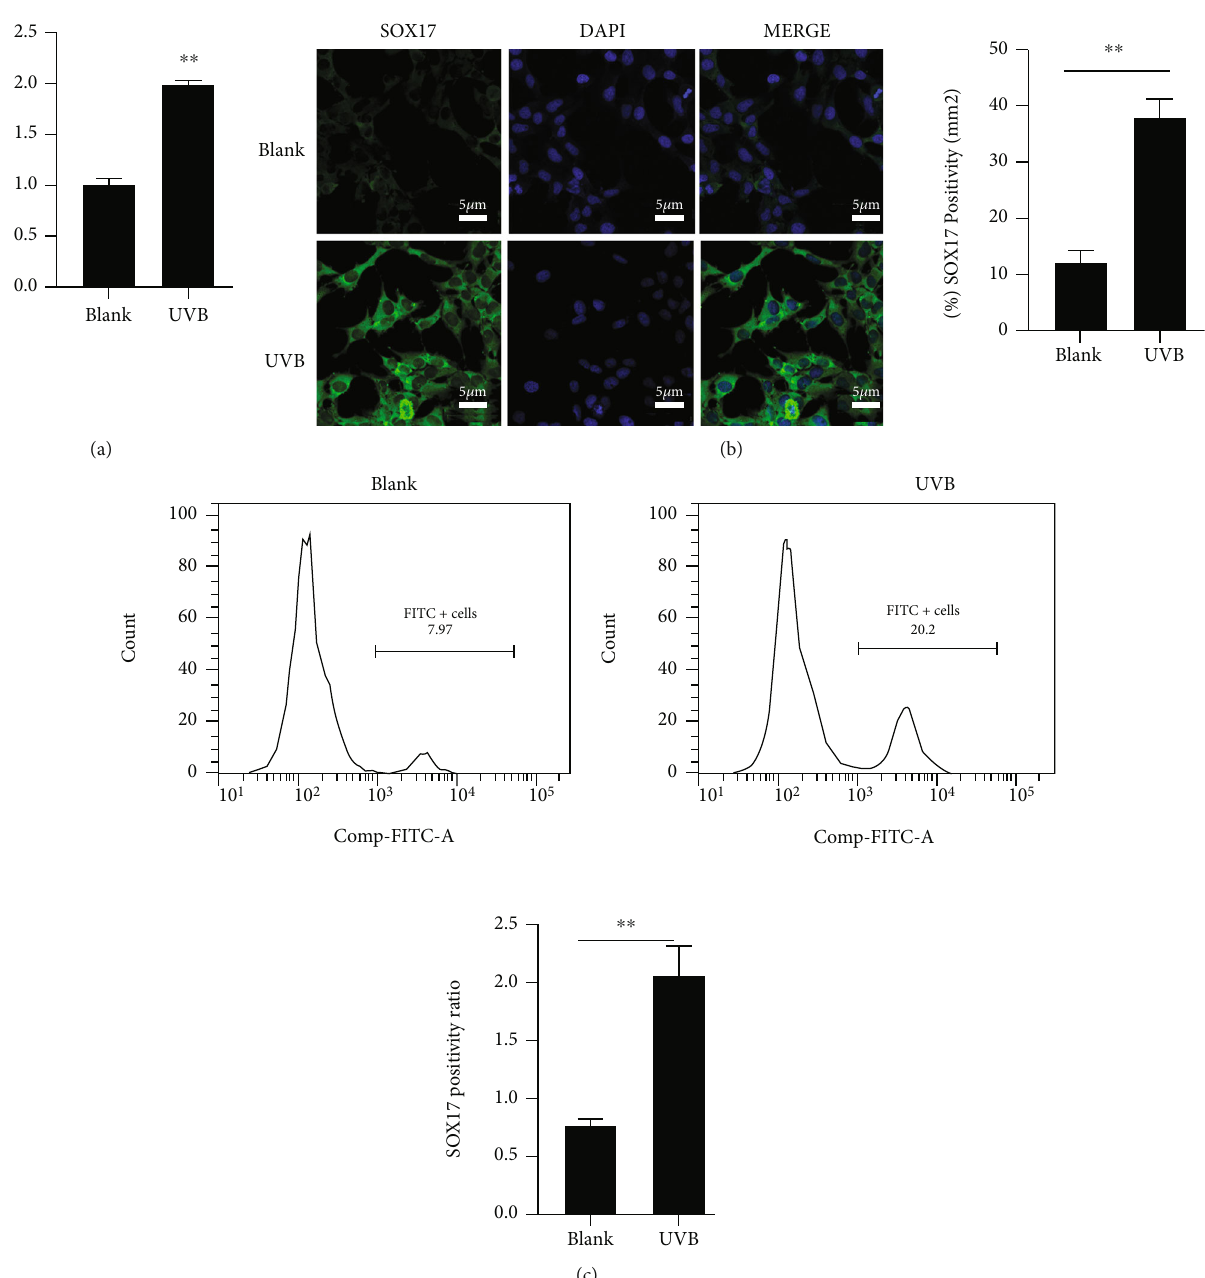
Figure 5: Ultraviolet B (UVB) irradiation enhances SOX17 expression in murine KCs post-UVB irradiation. (a) qRT-PCR determination of SOX17 mRNA expression in KCs following UVB irradiation. (b) Immuno fl uorescence analysis of SOX17 expression in KCs following UVB irradiation. (c) FCM detection of SOX17 expression in KCs. Data were obtained from three experiments run independently. Data points and error bars denote mean ± SEM . ∗∗ p < 0 : 01 . KC: